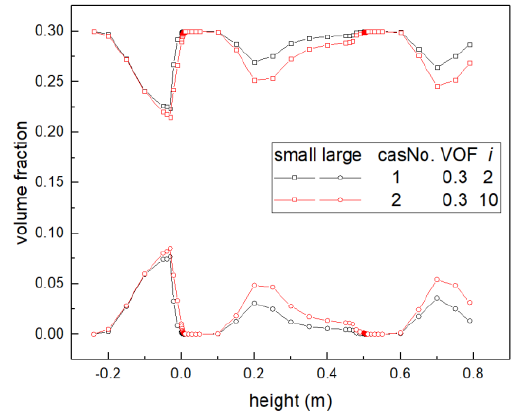
Figure 9. Volume fraction for large and small bubbles.